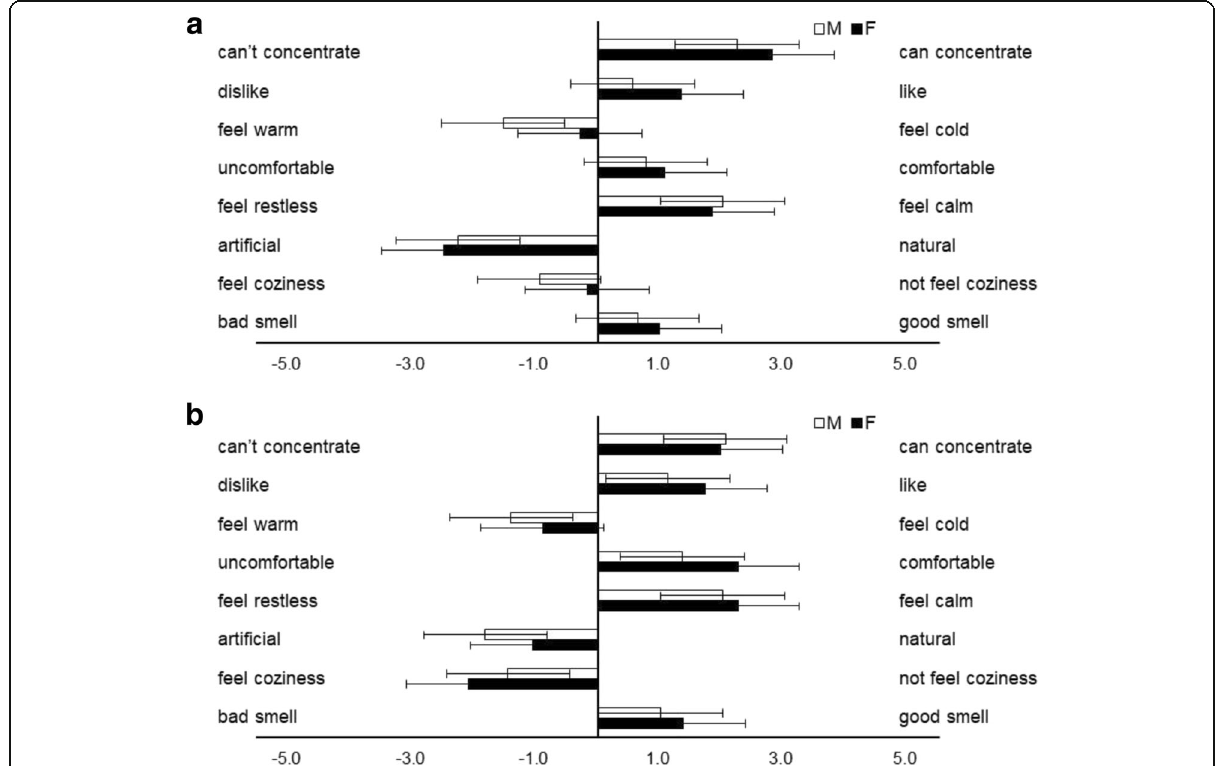
Fig. 2 Subjective effects of the odor of the experiment room. The bars in a show the visual analog scale scores reported by participants in the control condition: male participants (white) and female participants (black). Differences between conditions were not significant. Data are shown as mean± SEM. The bars in b show visual analog scale scores reported by participants in the Japanese cedar wood panels (experimental) condition; male participants (white) and female participants (black). Differences between conditions were not significant. Data are shown as